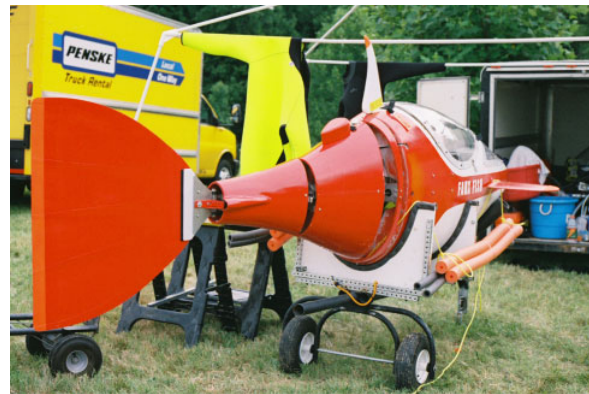
Figure 6 Human-powered submarine using lateral caudal undulations of a flexible and jointed tail fin.